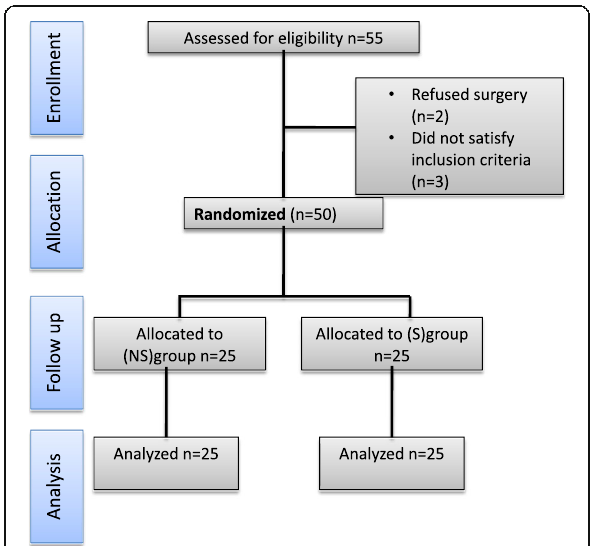
Fig. 1 Study flowchart. Group (NS) combined neostigmine and ½ dose sugammadex group. Group (S) sugammadex alone